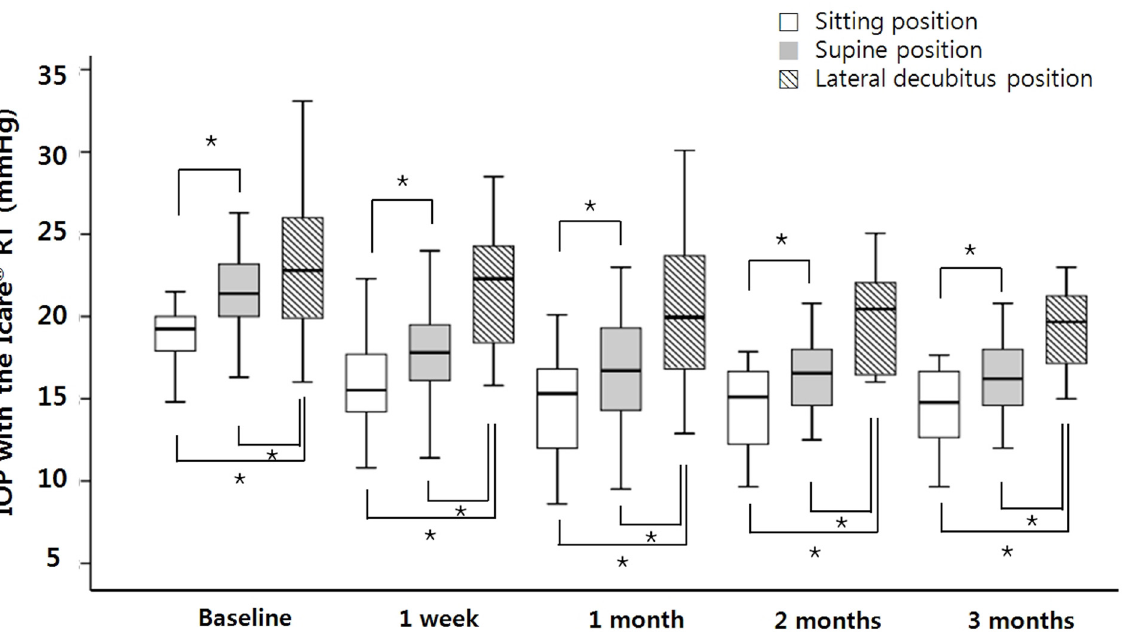
Fig 1. Posture-induced intraocular pressure (IOP) changes before and after ALT over a 3-month follow-up period. Compare to baseline value, IOPs in each position were significantly decreased at every time point of the follow-up period ( P < 0.001; repeated measures analysis of variance followed by Bonferroni post-hoc test). Compare to sitting position, the IOP in the supine position and dependent lateral decubitus position (DLDP) were significantly higher at every time point of the follow-up period ( P < 0.001; paired t -test). Also, the IOP between supine position and DLDP during follow-up were significantly different ( P < 0.001; paired t -test). Box plots illustrate the median (50th percentile) as a black center line and the edges of the box are the 25th and 75th percentiles. The whiskers extend to largest and smallest values within 1.5 interquartile range. * P < 0.05